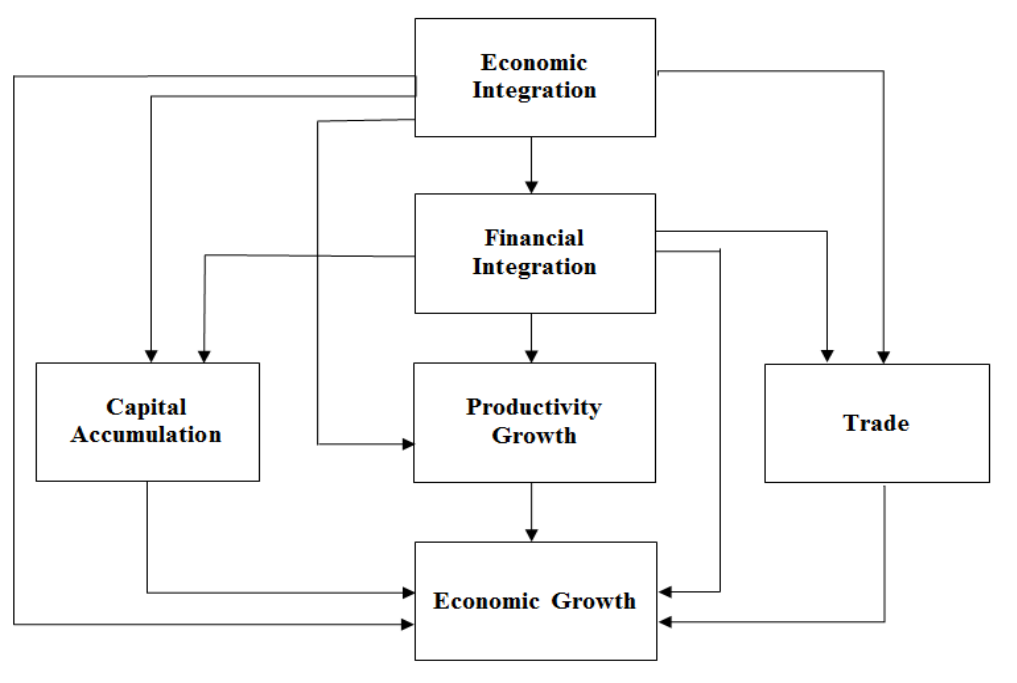
Figure 1 : The conceptual framework of the possible patterns of relationship among economic